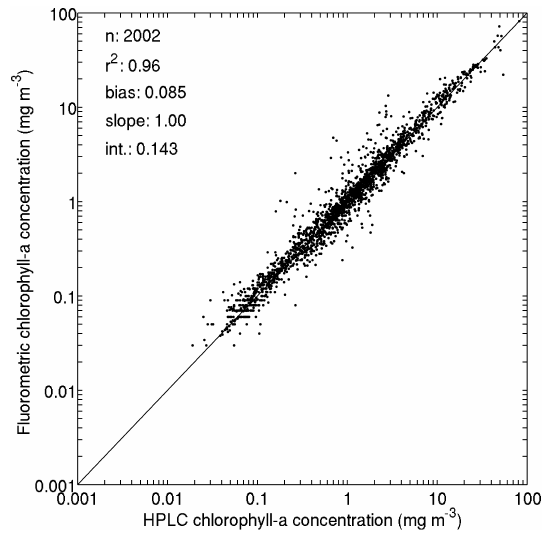
Figure 6. Comparison of coincident observations of chloro- phyll a concentration derived with different methods (chla_fluor and chla_hplc). The data were transformed prior to regression anal- ysis to account for their log-normal distribution.